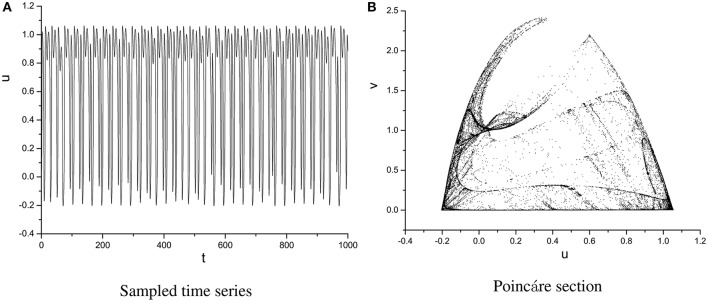
Sampled time series (A) and its Poincáre section (B) as ω = 0.6.